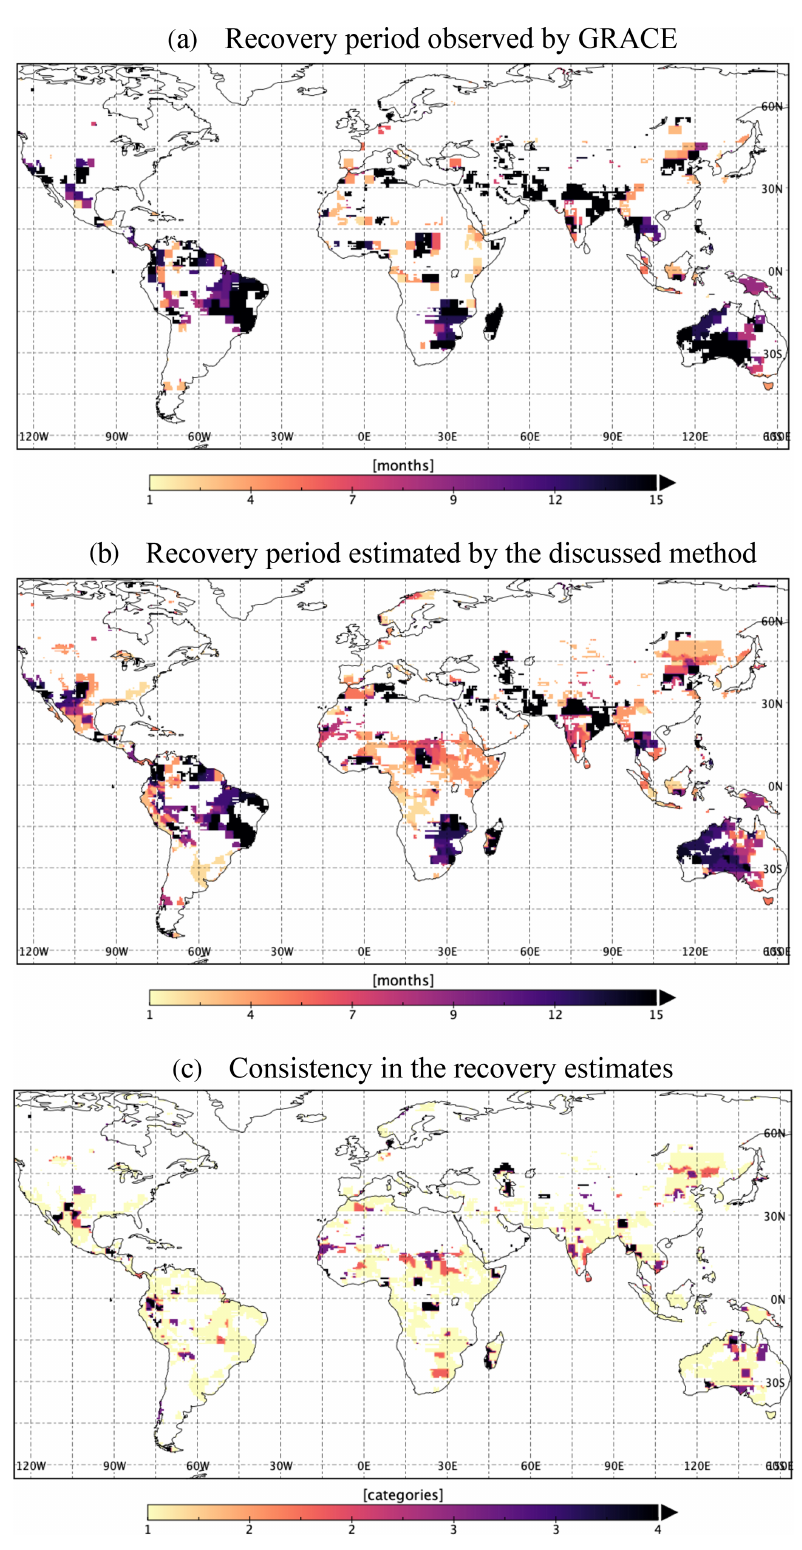
Figure 8. Validation of the estimated required precipitation by the recovery duration from the January 2016 drought observed from (a) GRACE and (b) estimated, by the discussed method, using GRACE and GPCP observations. (c) Consistency in the observed recovery duration by GRACE and GPCP (1 = 1–2 months’ difference, 2 = 3–4 months’ difference, 3 = 5–8 months’ difference and 4 = 9 + months’